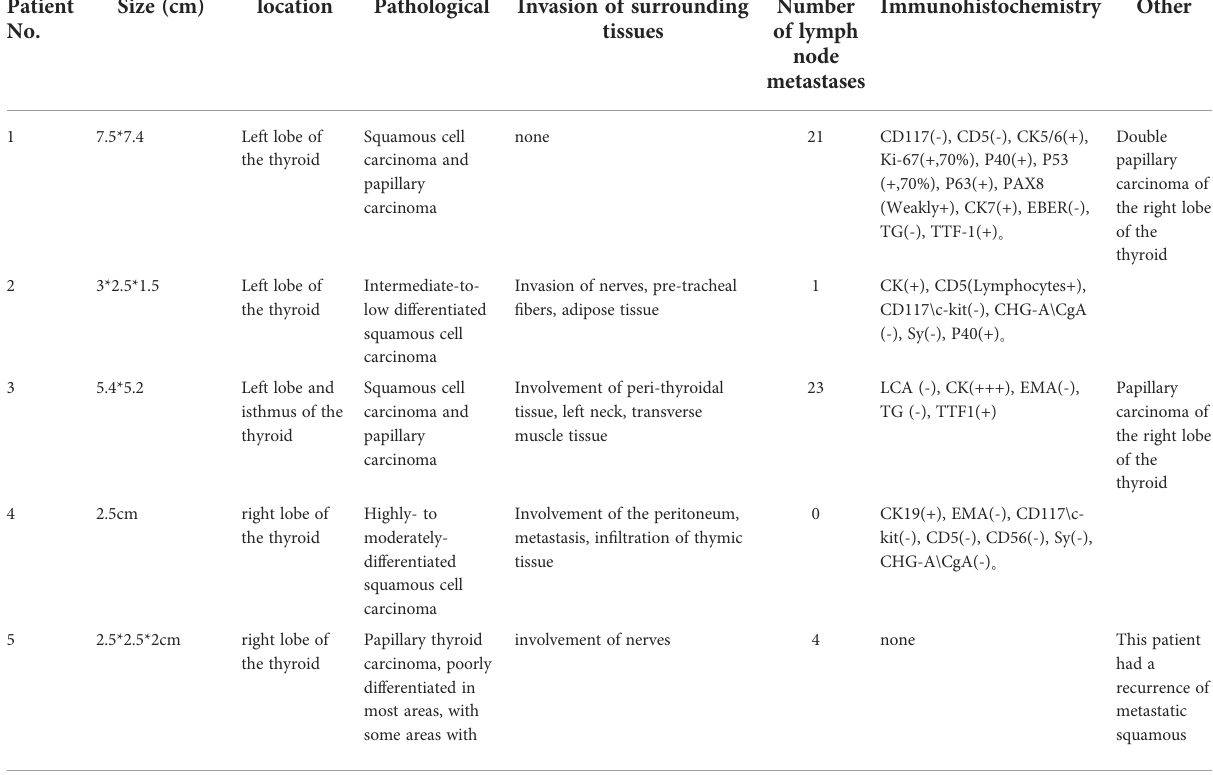
TABLE 4 Pathological characteristics of patients with